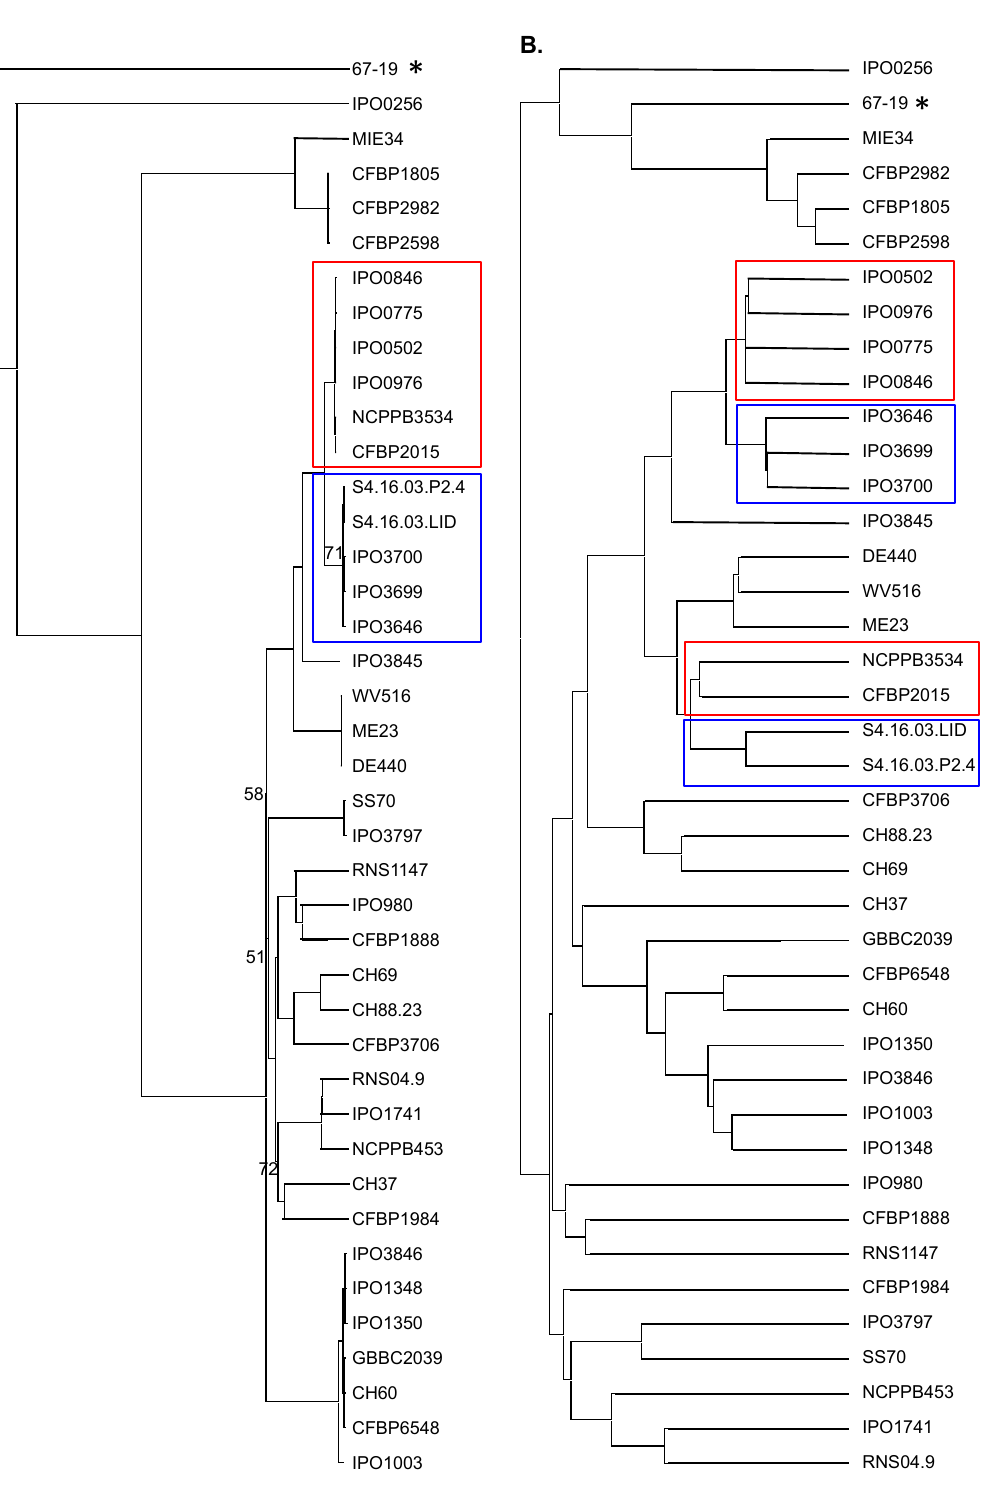
Figure 2. Phylogeny of Dickeya dianthicola . ( A ). Phylogenic tree built up from the concatenated sequences of 2996 homologous protein sequences (19,293 variable sites). One hundred bootstrap replicates were performed to assess the statistical support of each node. Only bootstraps values below 100% are presented. ( B ). Pangenome tree: distance was calculated from a presence/absence matrix of the pangenome (see Section 2). Stars and rectangles indicate differences between both